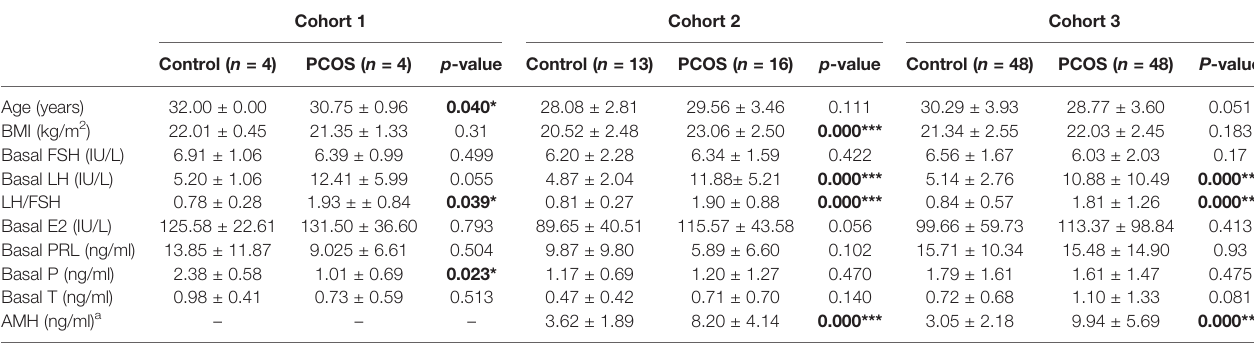
TABLE 1 | Characteristics of the PCOS and control patients. Cohort 1 Cohort 2 Cohort 3 Control ( n = 4) PCOS ( n = 4) p -value Control ( n = 13) PCOS ( n = 16) p -value Control ( n = 48) PCOS ( n = 48) P -value